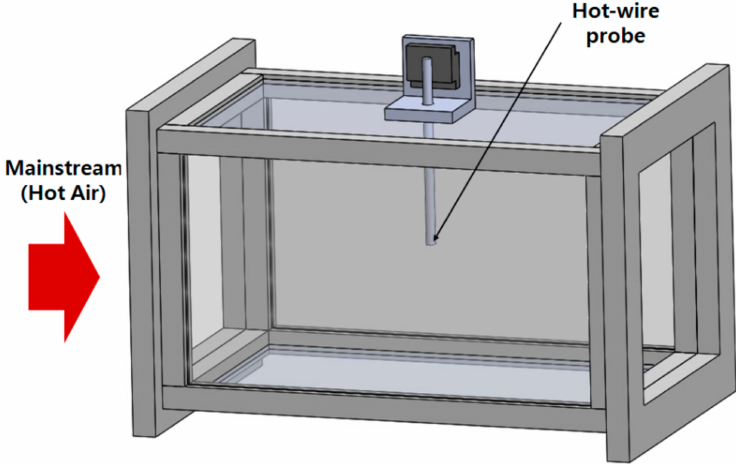
Figure 6. Schematic diagram of test section and hot wire probe.